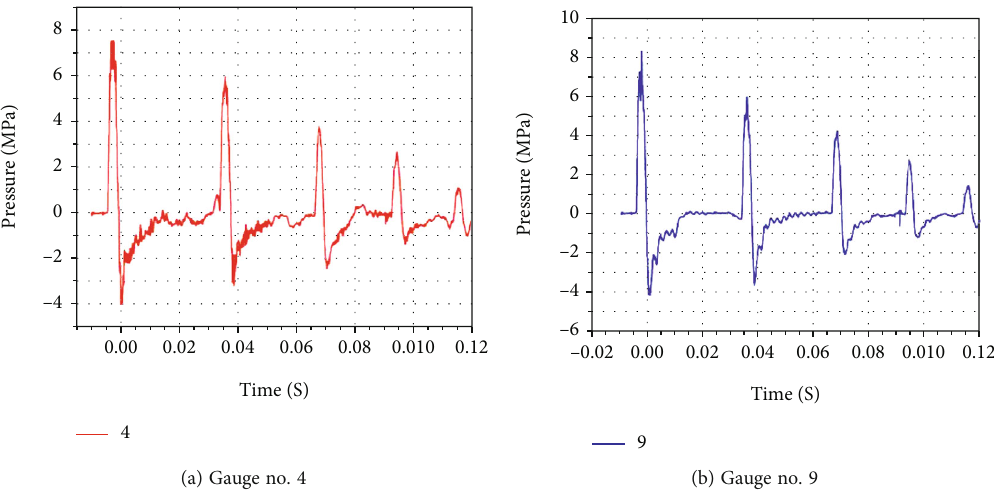
Figure 15: Stress curves of the whole experiment.